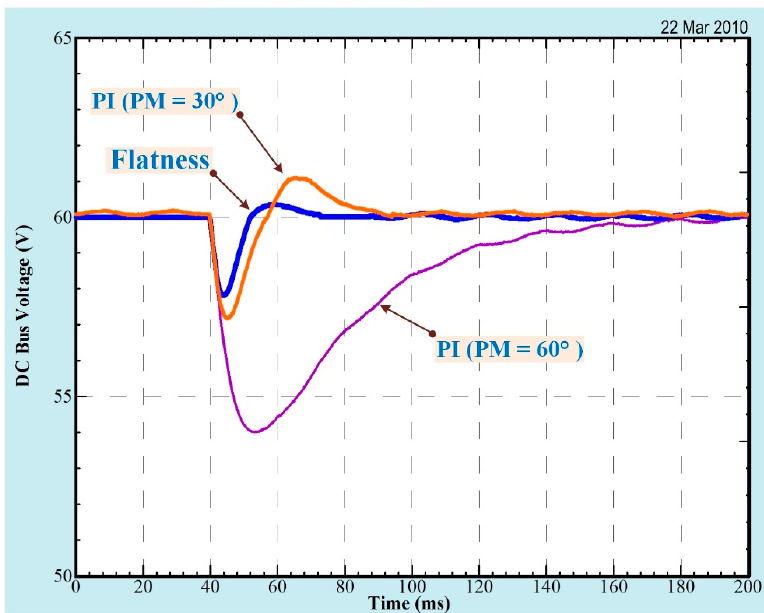
Figure 3. Test bench results: comparison of the performance between a basic PI control law and the differential flatness-based control algorithm with a dc-grid voltage stabilization of 60 V during a high power load change from 0 W to 750 W at t = 40 ms, adapted from Thounthong et al. [31].